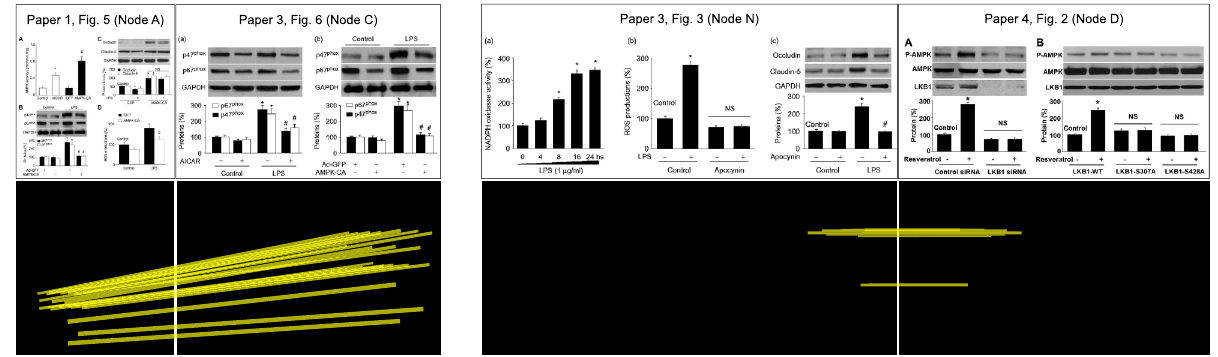
Figure 8. Details of two edges computed by SILA within the provenance graph depicted in Fig. 7b. In ( a ), the depiction of the shared content between nodes A and C , whose relation is documented in the respective retraction notice. In ( b ), the depiction of the shared content between nodes N and D , after a mirroring operation over D . Image N is not identified as sharing content within the retraction notice, suggesting the relation N - D was not found by a human analyst before. The four top panels herein presented belong to the following papers: (i) “Paper 1, Fig. 5”, reprinted from Experimental and Molecular Pathology, 97, Zhao et al., “Activation of AMPK attenuates lipopolysaccharide-impaired integrity and function of blood-brain barrier in human brain microvascular endothelial cells”, 386-392, 2014, with permission from Elsevier; (ii) “Paper 3, Fig. 6” and “Paper 3, Fig. 3”, “Activation of AMPK improves lipopolysaccharide-induced dysfunction of the blood-brain barrier in mice”, Yu et al., Brain Injury, March 3, 2015, reprinted by permission of the publisher, Taylor & Francis Ltd; and (iii) “Paper 4, Fig. 2”, “Resveratrol via activation of LKB1-AMPK signaling suppresses oxidative stress to prevent endothelial dysfunction in diabetic mice”, Hu et al., Clinical and Experimental Hypertension, May 5, 2016, reprinted by permission of the publisher, Taylor & Francis Ltd. The bottom row panels represent the masks of the respective top images, with the respective positions of duplicated content found by SILA linked through yellow lines. By indicating here the duplicated content, we are not claiming this is the outcome of a mistake or misconduct.